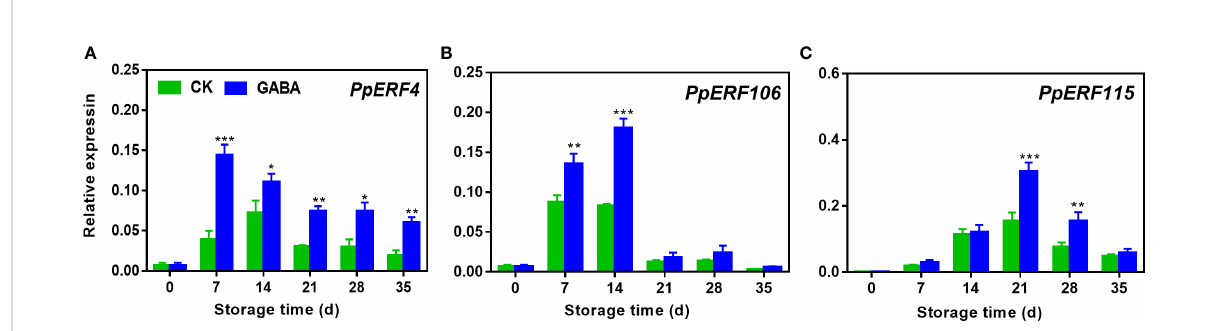
FIGURE 7 Effect of GABA treatment on expression of ERF transcription factors of peach stored at 4°C. Expression levels of PpERF4 (A) , PpERF106 (B) and PpERF115 (C) were analysed. Asterisks indicate signi fi cant differences between CK and GABA treatment (*p < 0.05, **p < 0.01, and ***p <